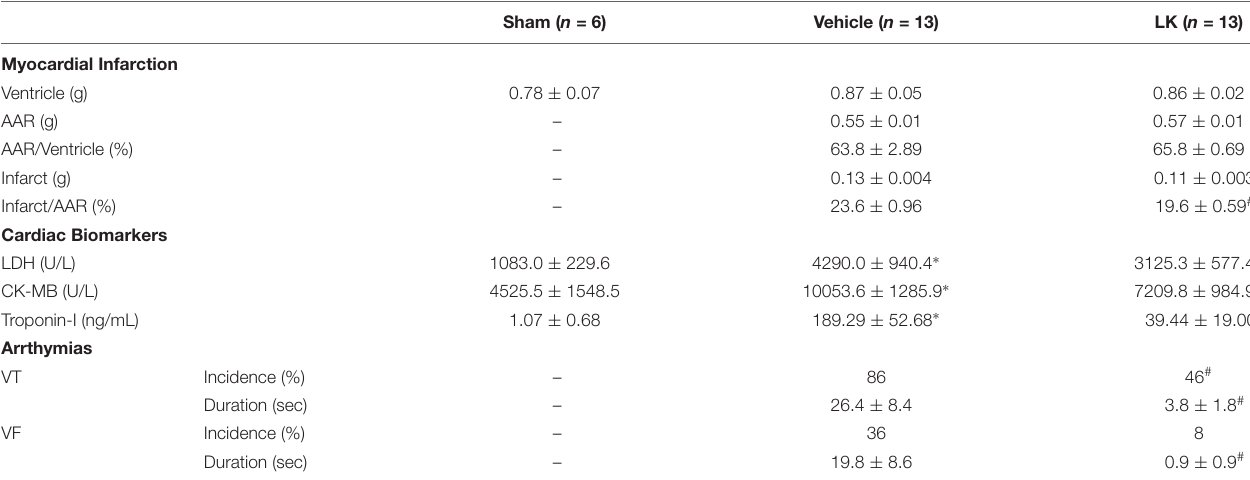
TABLE 1 | Effects of post-ischemic lumbrokinase treatment in rats subjected to myocardial I-R